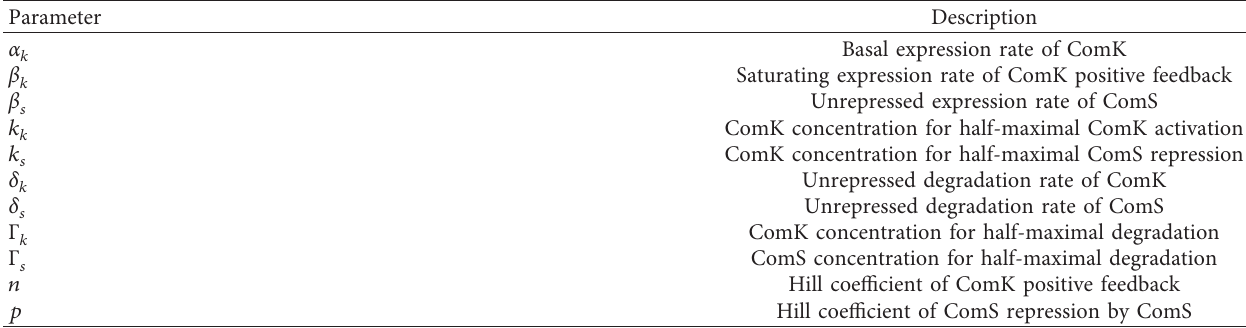
Table 1: Description of parameters in the dynamical